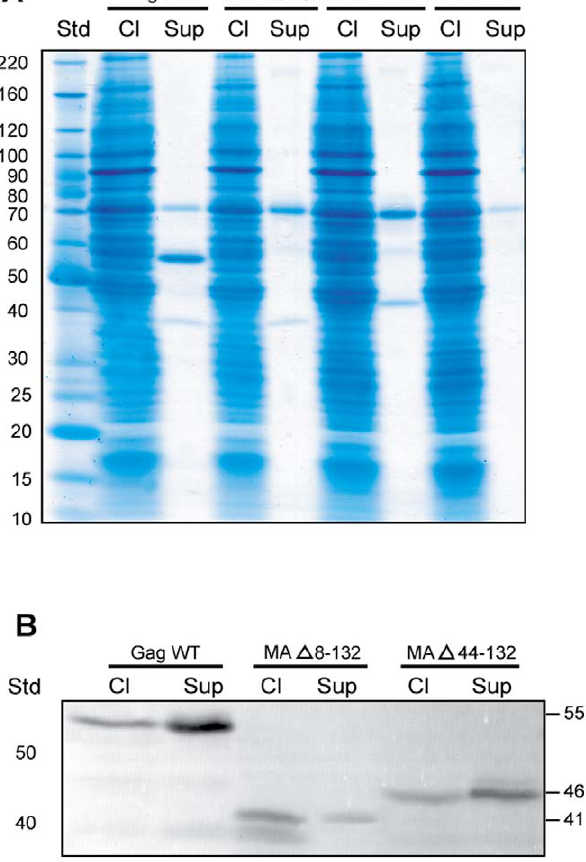
Figure 4. MA region is not required for VLP production. (A) 293T cells were transfected either with Gag WT, MA mutants (i.e. MA D 8–132 and MA D 44–132) or pcDNA3.1 ( + ) vector. At 48 h post-transfection, both the cell lysates and cell-free supernatants were analyzed on a gradient SDS-PAGE with Coomassie Brilliant Blue staining. (B) In parallel, an IP assay was performed using the anti-p24 antibody on the same samples. Precipitated proteins were run on gradient SDS-PAGE and Gag proteins were analyzed by Western Blotting (WB). The Biochemical experiments shown are representative of at least three independent